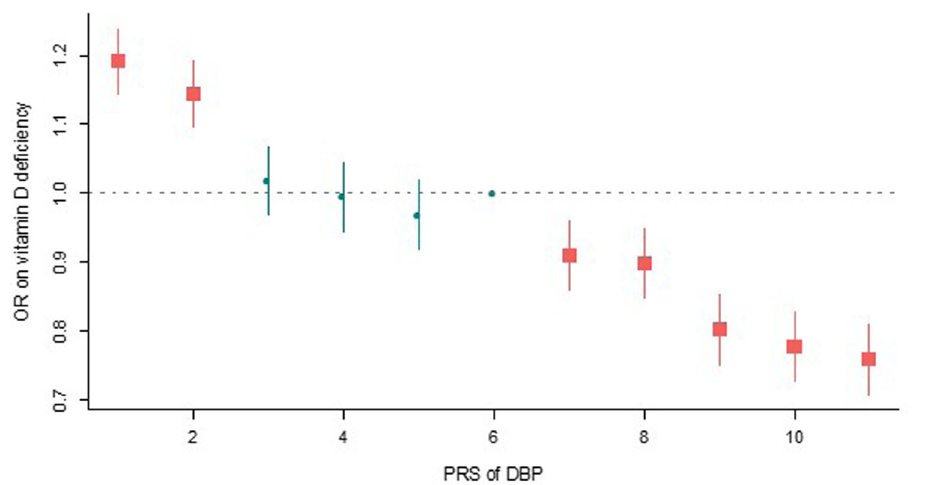
Fig.7|Oddsratio(OR)ofDBPPRSonvitaminDde fi ciency. ThePRSofDBPwas divided into 11 bins. The sixth bin with the average of PRS is set as the reference category(oddsratio=1).Weconductedalogisticregressionforeachbintotestthe oddsratioofPRSforbinofinterestcomparedtothereferencebin.Thesamplesize was 31,615 for each bin. The number of cases/controls of vitamin D de fi ciency (vitamin D <25nmol/L) were bin #1=4207/24,604, bin #2=4058/24,752, bin #3=3684/25,105, bin #4=3595/25,115, bin #5=3525/25,308, bin #6=3622/25,251, bin #7=3329/25,474, bin #8=3307/25,518, bin #9=2982/25,820, bin #10=2906/